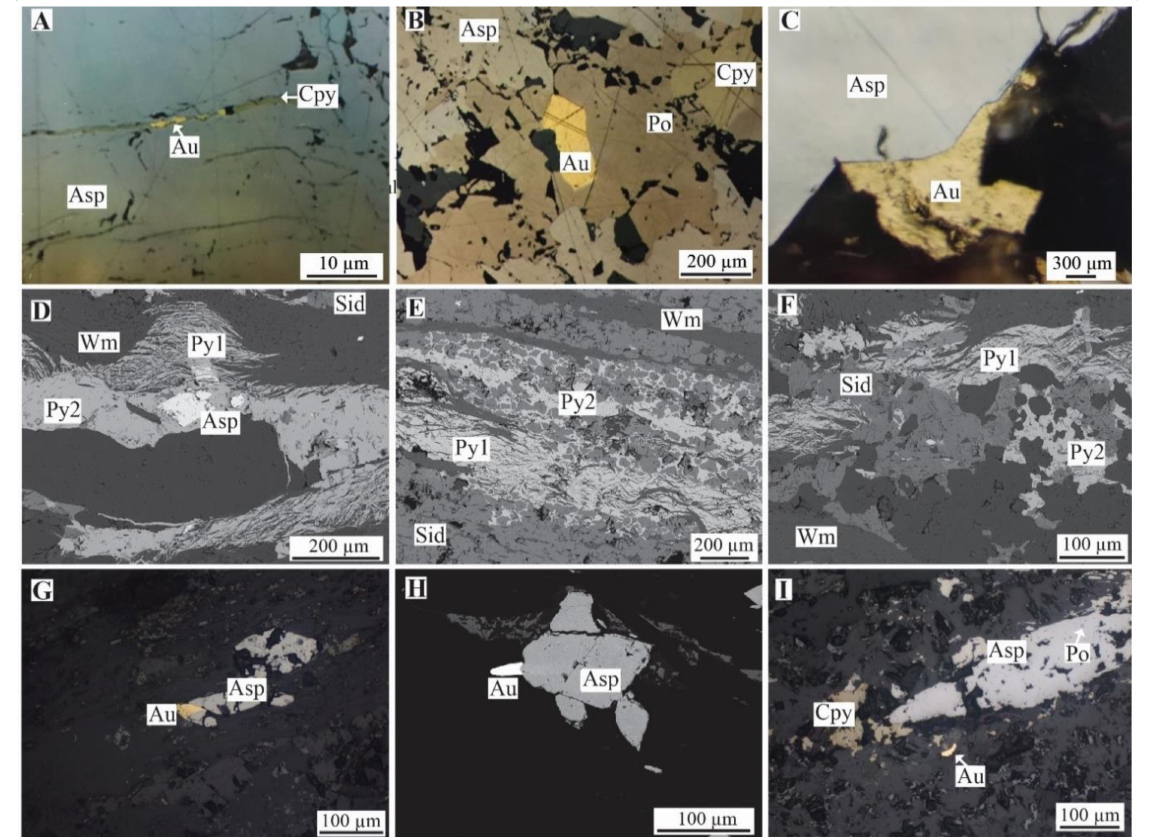
Figure 5. Photomicrographs showing ore assemblage, mode of occurrence and distribution of gold in the GAB deposits. ( A ) Gold and Cpy filling microfracture in Asp of massive sulfide ore in Mina III deposit [119]; ( B ) gold ( ≤ 200 µ m) with Po-Cpy-Asp of massive sulfide from Mina III deposit [119]; ( C ) native Au bordering Asp from disseminated mineralization in the Maria L á zara deposit. Dissolution microcavities in gold grains suggest remobilization processes [14]; ( D ) idiomorphic Asp overprinting sulphides (Py1 and Py2) in proximal BIF at the Sert ã o deposit [106]; ( E ) textural contrast of fine-grained, deformed Py1 and coarse-grained, poikiloblastic Py2 after replacement of ankerite/siderite in proximal BIF at the Sert ã o deposit [106]; ( F ) siderite overprinting Py1 and being replaced by Py2 in BIF at the Sert ã o deposit [106]; ( G ) gold ( ≤ 50 µ m) in equilibrium with Asp shows microfractures and dissolution features in proximal carbonaceous schist at the Sert ã o deposit; ( H ) BSE image of elongated Au (ca. 30 µ m) in equilibrium with Asp with pressure shadows filled by white mica in proximal carbonaceous schist at the Sert ã o deposit [106], and ( I ) free Au (ca. 20 µ m) adjacent to subhedral Asp-Py-Cpy in BIF at the Sert ã o deposit [106]. Abbreviations correspond to Asp: arsenopyrite, Cpy: chalcopyrite, Py: pyrite, Po: pyrrhotite, Sid: siderite, Au: gold, Wm: white